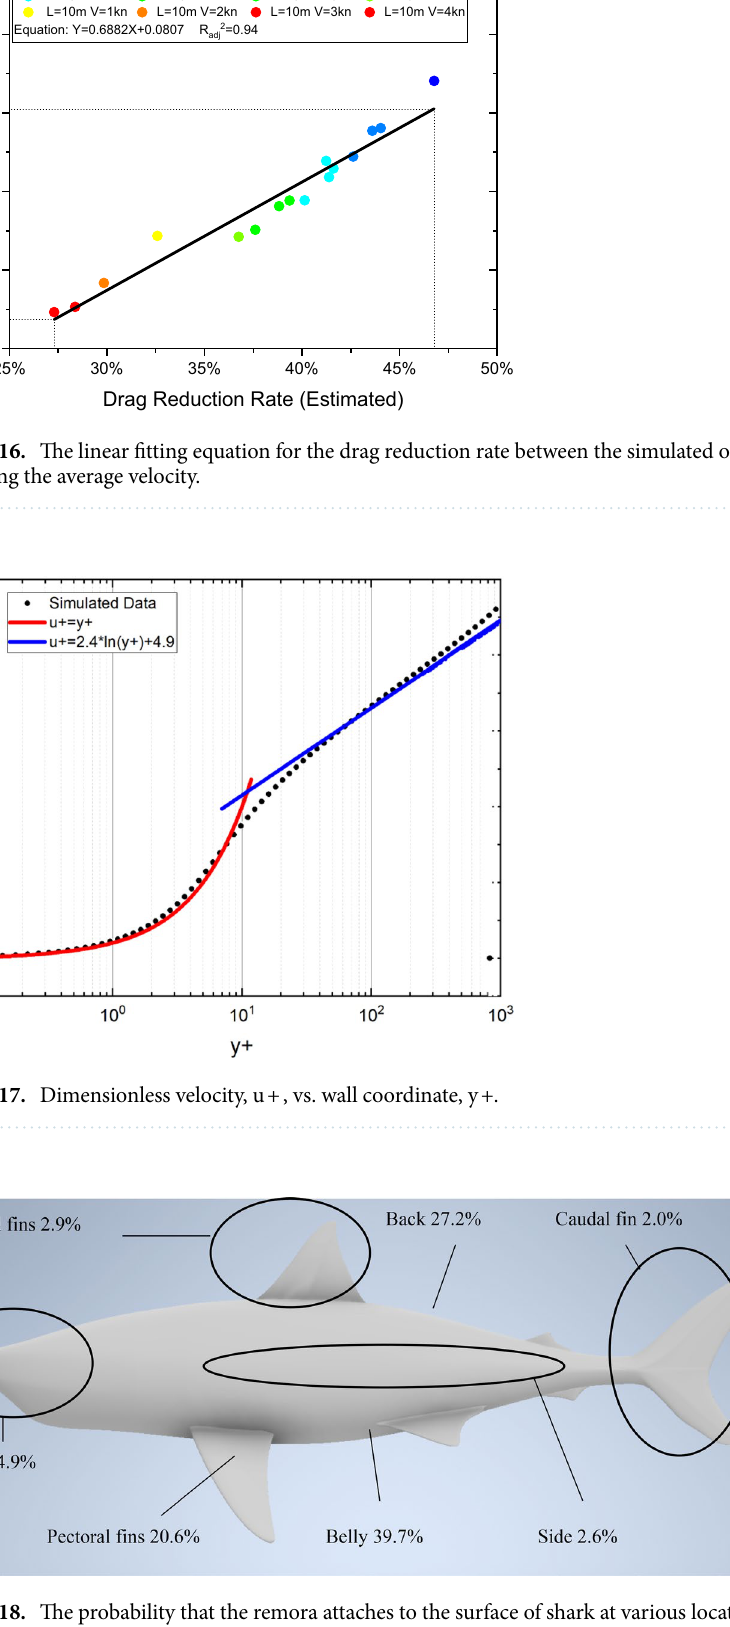
Figure 18. The probability that the remora attaches to the surface of shark at various locations (reproduced based on 8